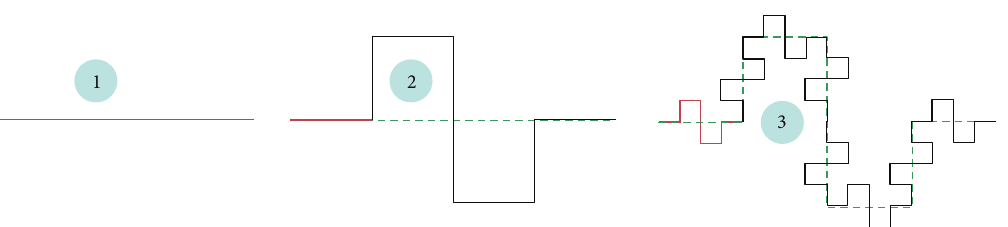
Figure 11: The first two iterations, 𝑖 = 0 → 2 , of the hybrid meander-Koch curve for the optimum case of 𝑛 = 4 subdivisions.